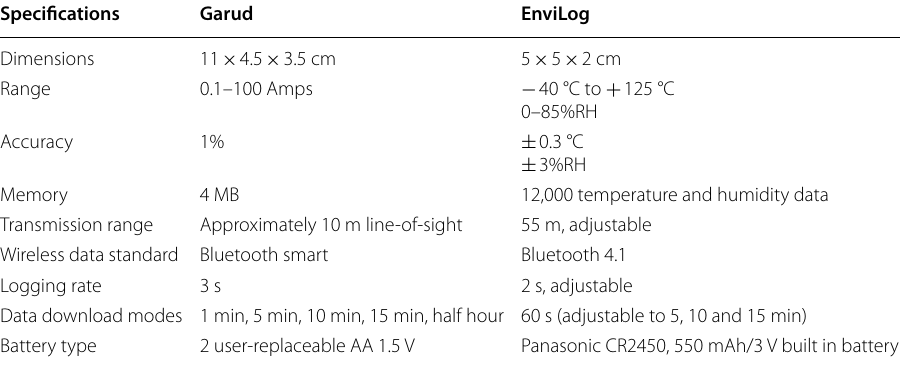
Table 2 Specifications of Garud logger and EnviLog